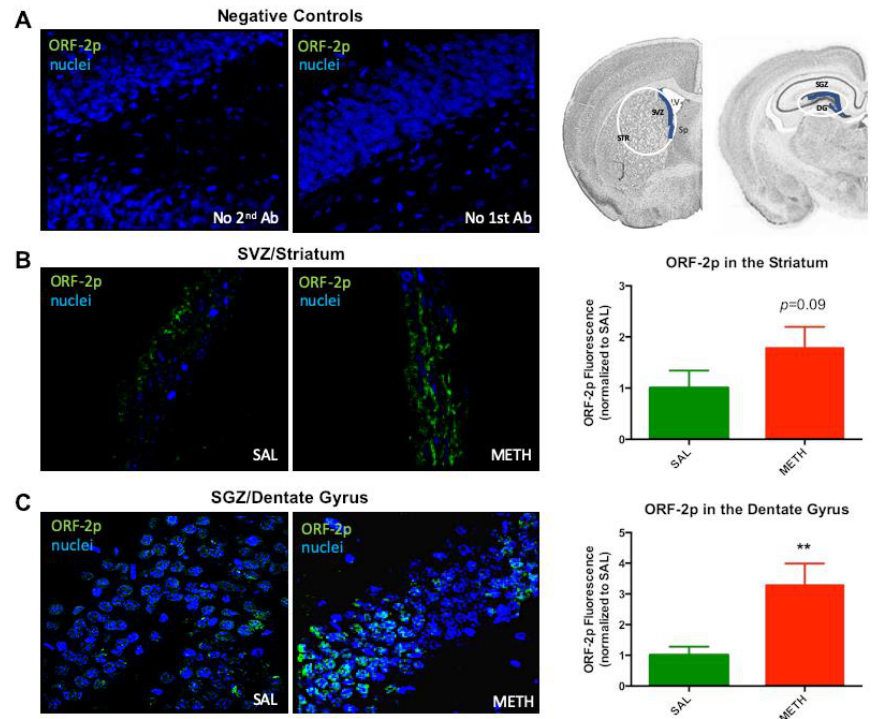
Figure 3. The effect of two daily 20 mg/kg METH doses on ORF-2p immunoreactivity in rat striatum and dentate gyrus at 24 h after the 2nd injection of METH or saline. ( A ) No-secondary (2nd) antibody control, no-primary (1st) antibody control and graphic presentation of dissected out tissue (white ovals), with delineated subventricular and subgranular zones (SVZ and SGZ, blue lines). ( B ) ORF-2p immunoreactivity in the SVZ. ( C ) ORF-2p immunoreactivity in the SGZ and dentate gyrus. Abbreviations: METH, methamphetamine; SAL, saline; SGZ, subgranular zone; SVZ, subventricular zone; ORF-2p, ORF-2 protein. ** Statistical significance, p < 0.01, METH vs. SAL.